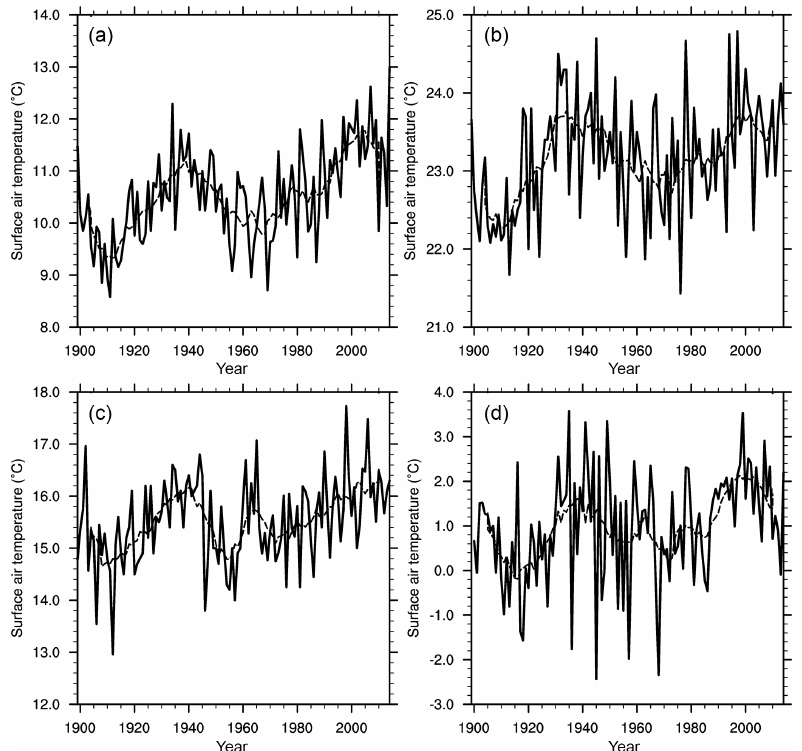
Figure 8. Constructed seasonal mean SAT series ( ◦ C) in Qingdao for the period 1899–2014 (solid line) and the 10-year running mean (dashed line). (a) Spring, (b) summer, (c) autumn and (d)